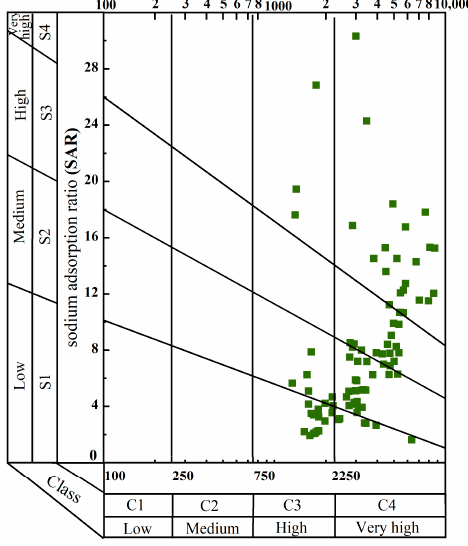
Figure 10. USSL classification chart of groundwater irrigation water quality.